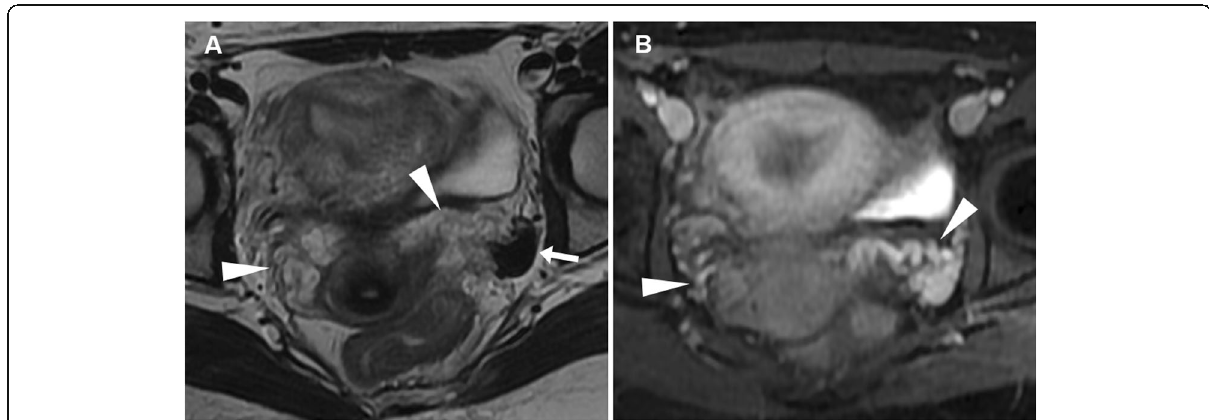
Fig. 22 MRI of pelvic congestion syndrome in a 26-year-old woman with chronic pelvic pain and a recent severe exacerbation. Oblique-coronal T2-weighted image ( a ) shows ectatic vascular structures in the parametria, showing predominantly high signal intensity (arrowheads); in the left parametrium, some varices (arrow) display low signal intensity. Corresponding oblique-coronal gadolinium-enhanced fat-suppressed T1-weighted image ( b ) demonstrates vascular enhancement of the abovementioned structures (arrowheads), thus confirming pelvic